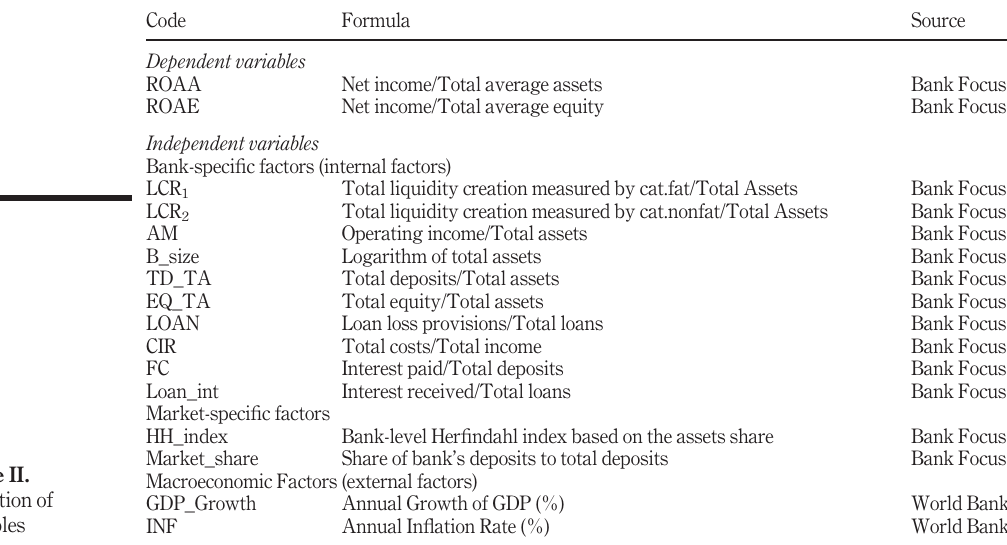
Table II. De fi nition of